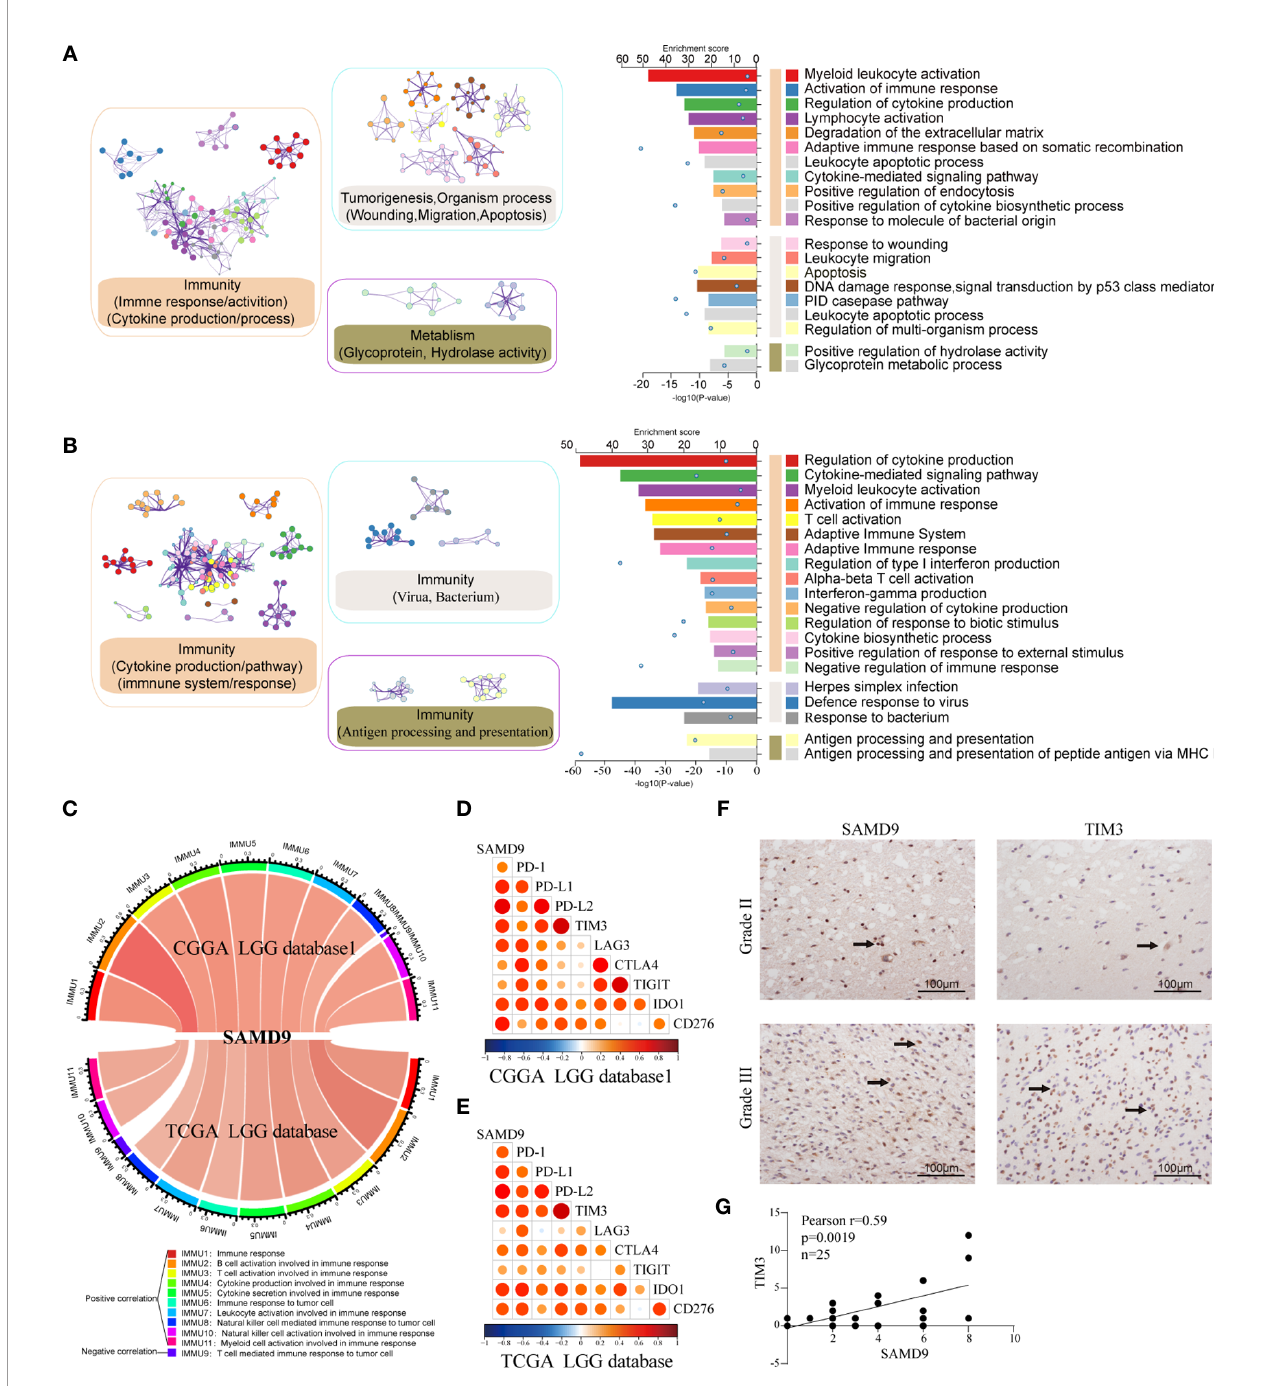
FIGURE 6 | Functional analysis of SAMD9 correlated genes relative to immune response. (A, B) . Functional enrichments of SAMD9 related genes (R > 0.5) in CGGA database 1and CGGA database, Cluster showed the possible functions of TOP 20 genes terms and description annotated the detailed pathways. Blue dots represent the enrichment scores of difference terms in the upper axis, the P -value of difference terms in the lower axis, all analysis was calculated by Metascape online. (C) The correlation coef fi cient between SAMD9 and different immune cells in CGGA and TCGA databases. IMMU9 represent a negative correlation and other IMMNUs represent a positive correlation. (D, E) Correlation Analysis of SAMD9 and nine immune-related checkpoints (PD-1, PD-L1, PD-L2, TIM3, LAG3, CTLA4, TIGIT, IDO1, CD276) in CGGA database 1 LGG and TCGA database LGG. Color depth and circle square represent the degrees of correlation. (F) SAMD9 and TIM3 expression levels in glioma specimens determined by IHC analysis in grade II and III. Scale bar = 100 m m. (G) Correlation analysis of SAMD9 and TIM3 immunohistochemical scores. X-axis, SAMD9 staining score; y-axis, TIM3 staining score; correlation coef fi cient r = 0.59; p =